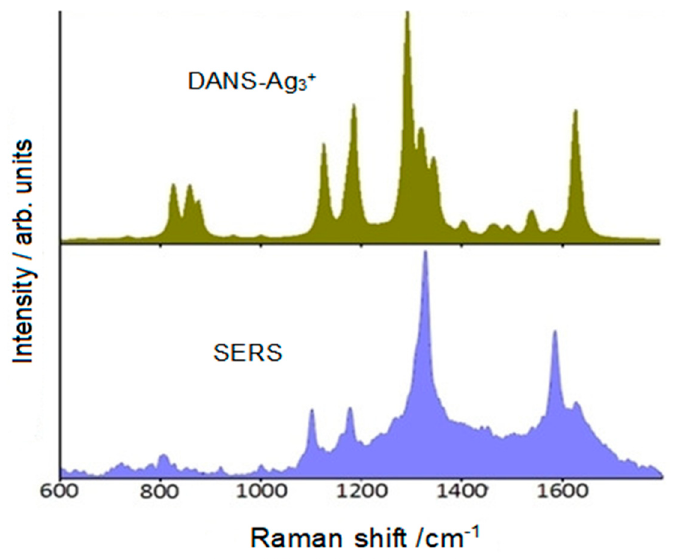
Figure 13. SERS spectrum of DANS and Raman spectra of DANS/Ag complex.